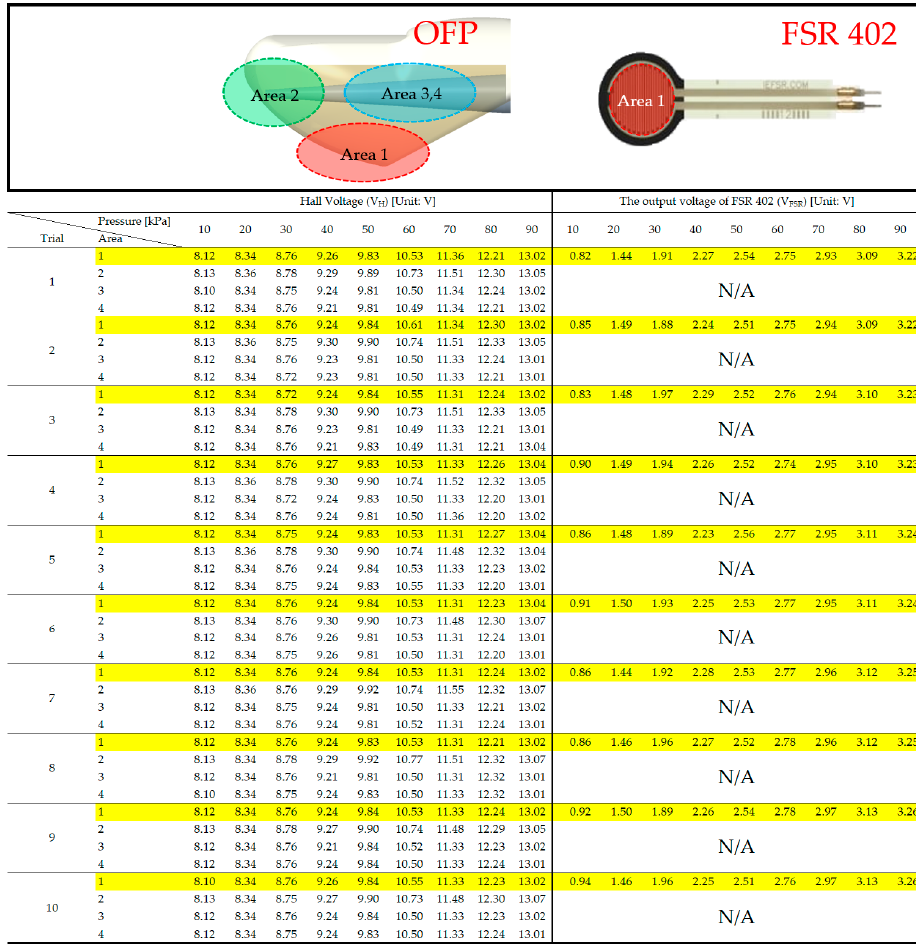
Figure 7. Experimental data measurements of OFP ( left ) and FSR402 sensor ( right ) over the general human touch pressure range.